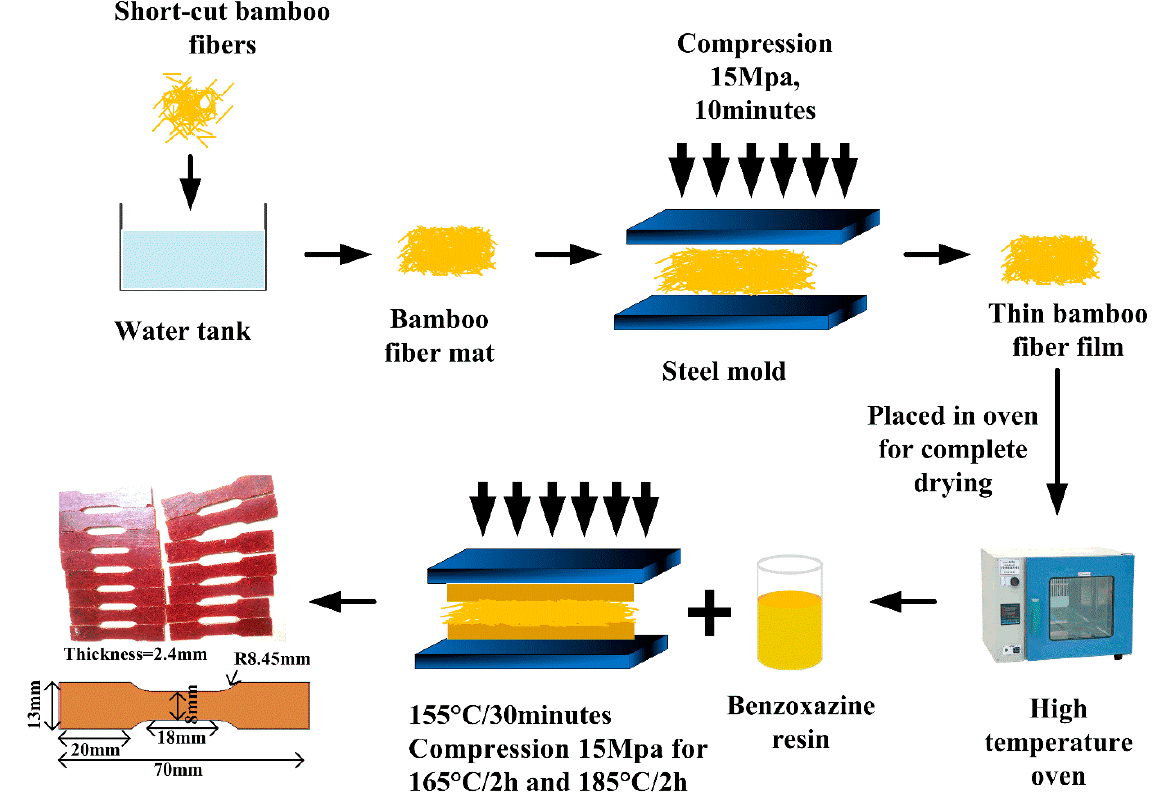
Figure 1. Schematic diagram of preparation of the chopped bamboo fiber-reinforced poly-benzoxa- Figure 1. Schematicdiagramofpreparationofthechoppedbamboofiber-reinforcedpoly-benzoxazinecomposite. zine composite.